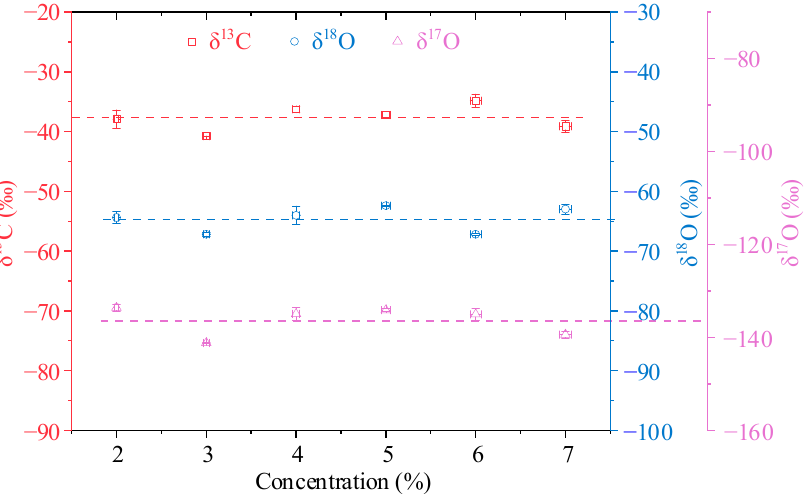
Figure 8. Calculated isotopic abundances of the diluted CO 2 gases with a total concentration of 2– 7%.